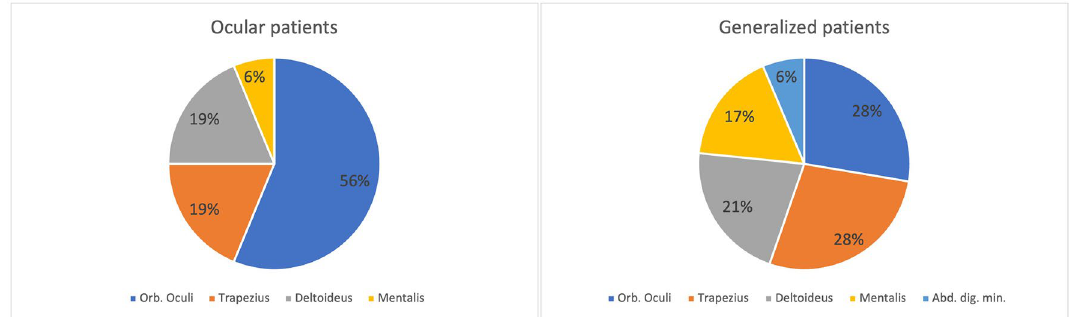
Figure 1. Frequency of muscles with highest CMAP decrement: While the orbicularis oculi muscle was the most affected muscle on RNS testing in ocular patients, the distribution was more even in generalized